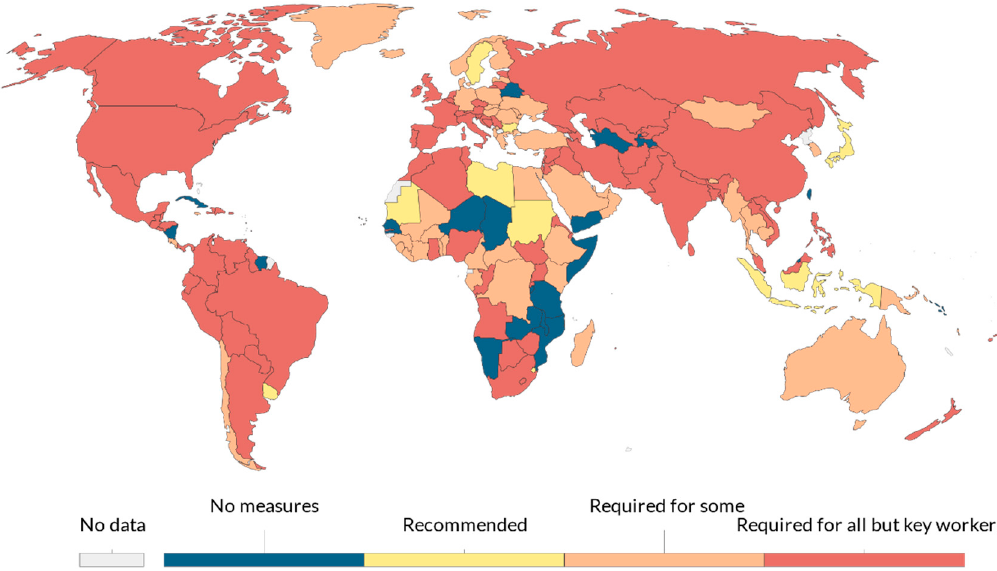
Figure 1. Workplace closures during the COVID-19 pandemic on 2 April 2020. There may be sub-national or regional differences in policies on workplace closures. The policy categories shown may not apply at all sub-national levels. A country is coded as “required closures” if some sub-national regions have required closures (source [2]).